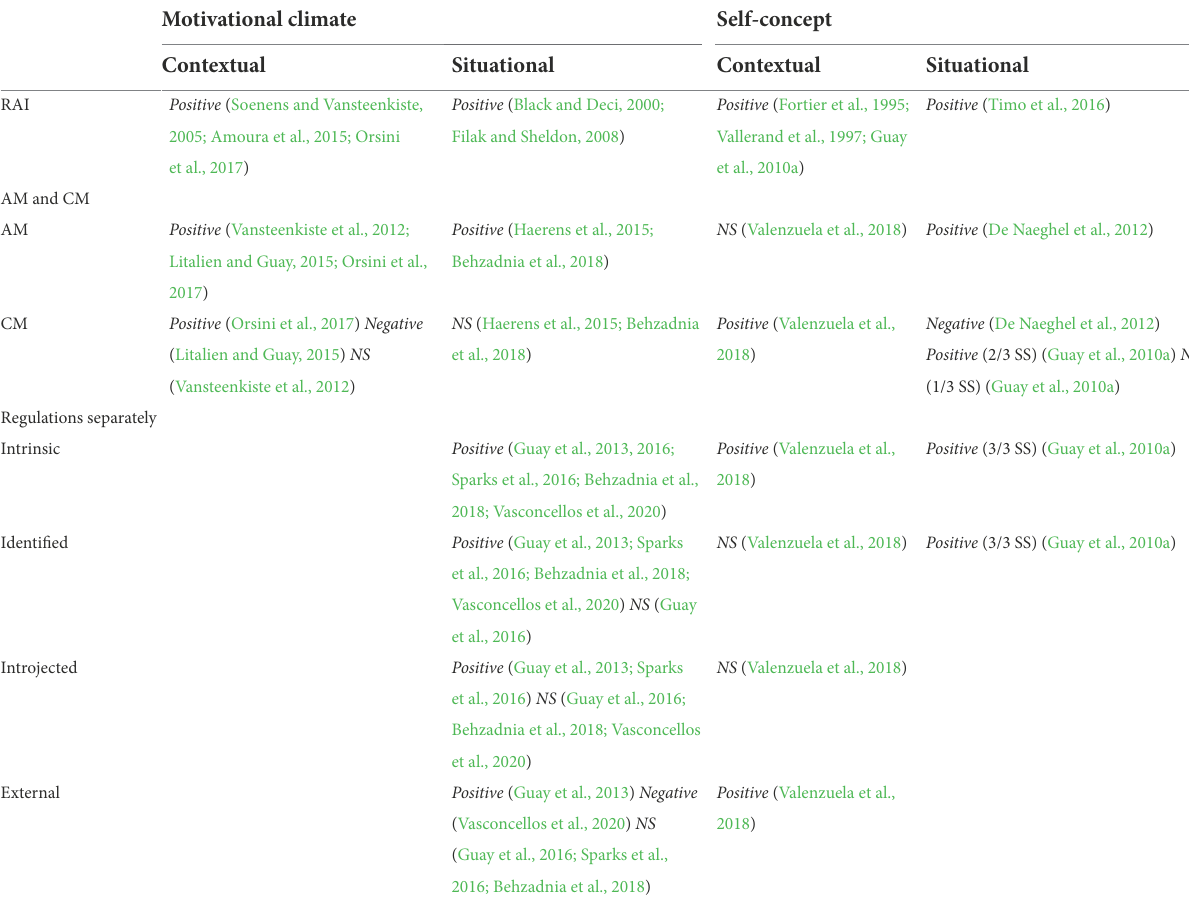
TABLE 1 Synthesis of the links observed in the studies between motivation and its antecedents according to the hierarchical level considered and the operationalization of the motivation